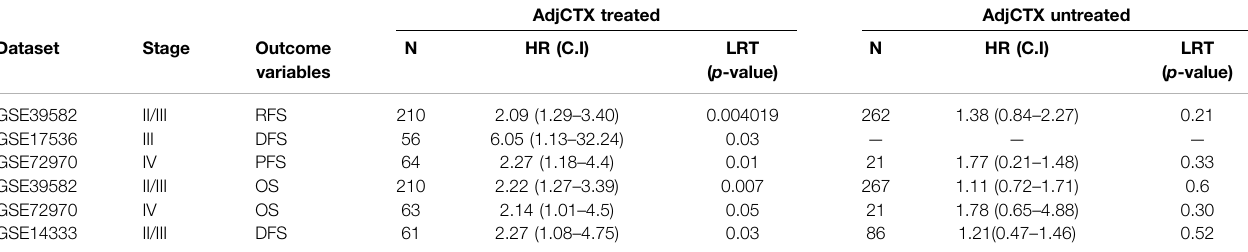
TABLE 1 | Summary table of the Cox proportional hazard model assessing the effect of ETV5 expression over adjCTX-treatment response in colon cancer patients.